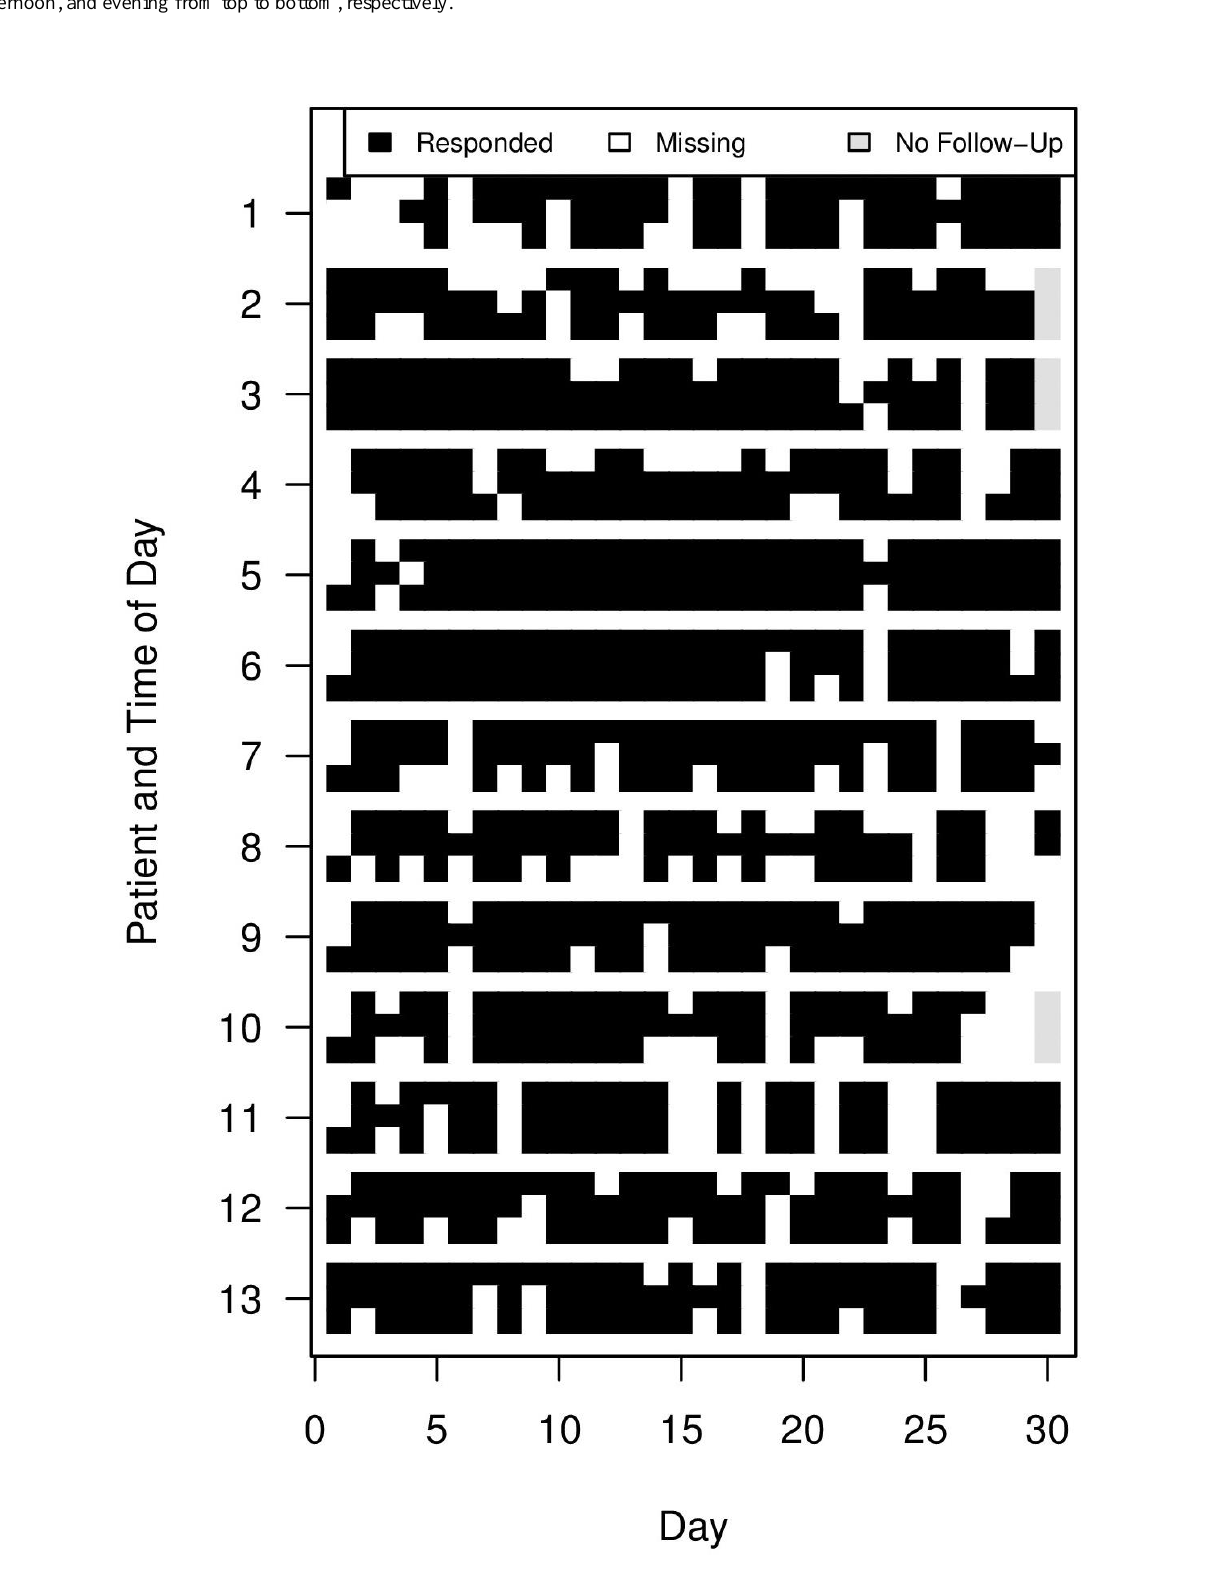
Figure 3. Adherence by patient, survey time, and day. Within patient rows, survey times are presented in columns of three, ordered as morning, afternoon, and evening from top to bottom,